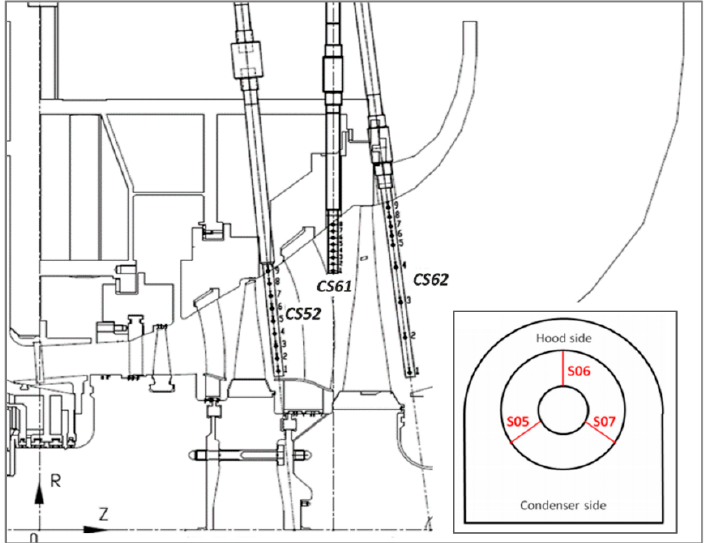
Figure 2. Detailed view of the model steam turbine rear stages and rake temperature measurements